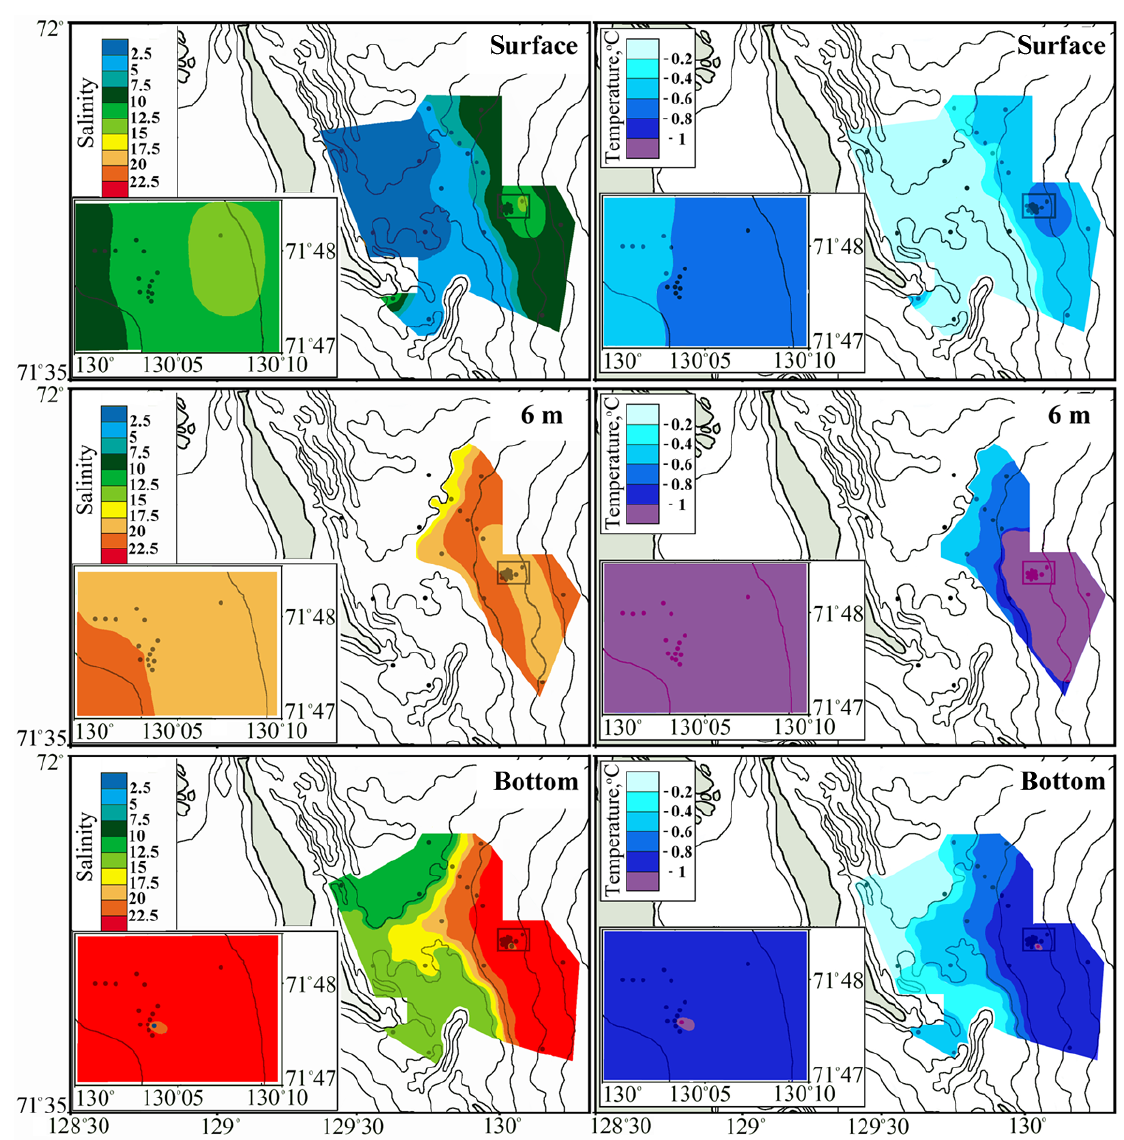
Figure 6. Salinity and temperature distribution of water at the surface, 6m deep, and at the bottom in the